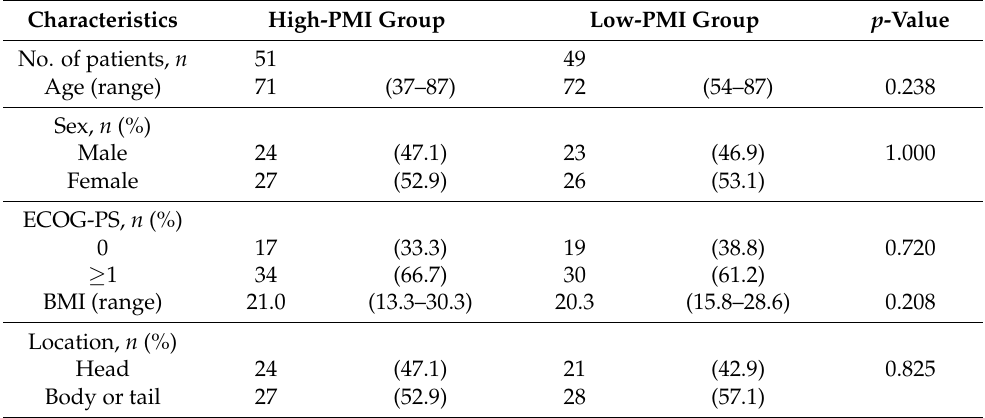
Table 1. Comparison of the clinical characteristics between the high- and low-PMI groups.